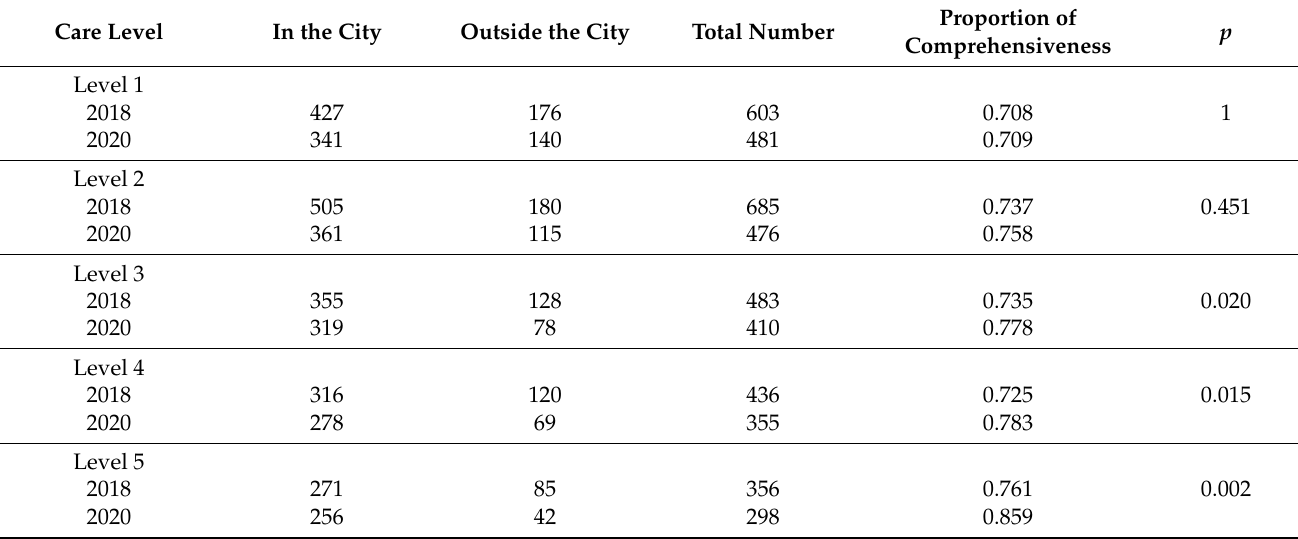
Table 2. Change in the proportion of comprehensiveness of medical care.